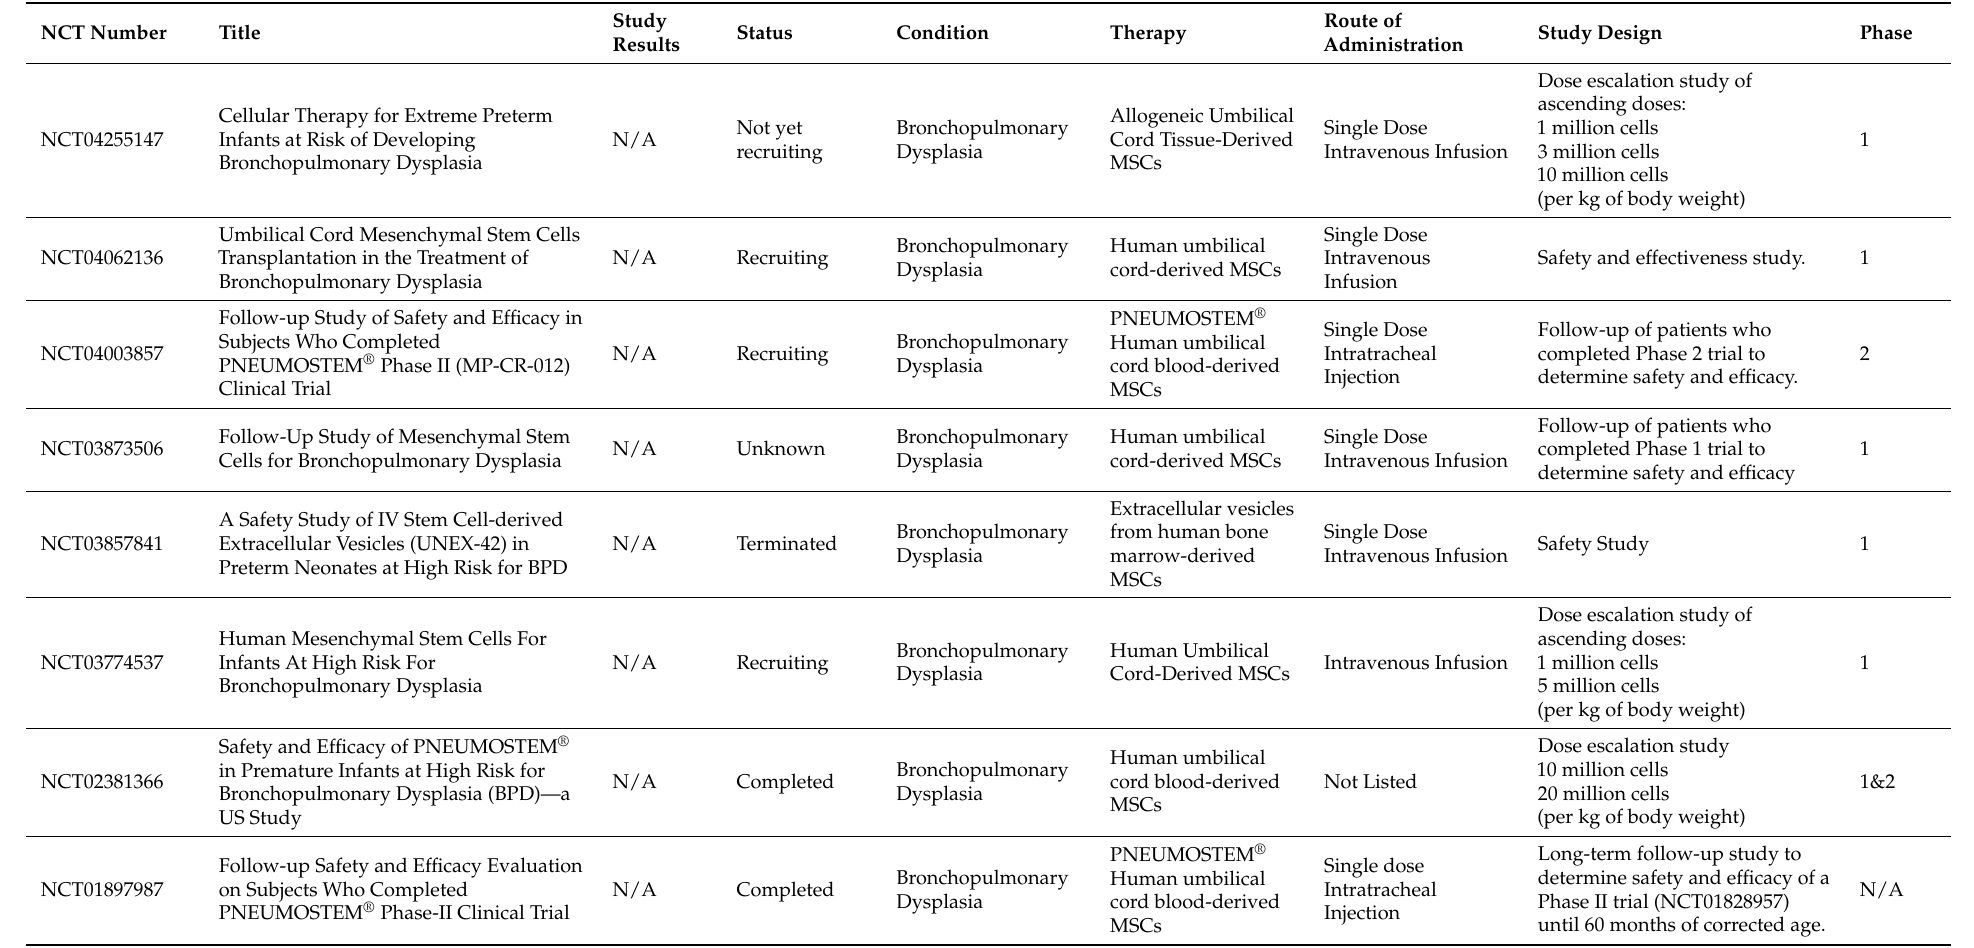
Table 1. Cellular based therapy for